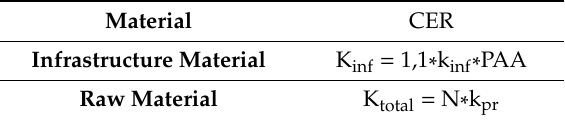
Table 8. CERs for Material and Infrastructure